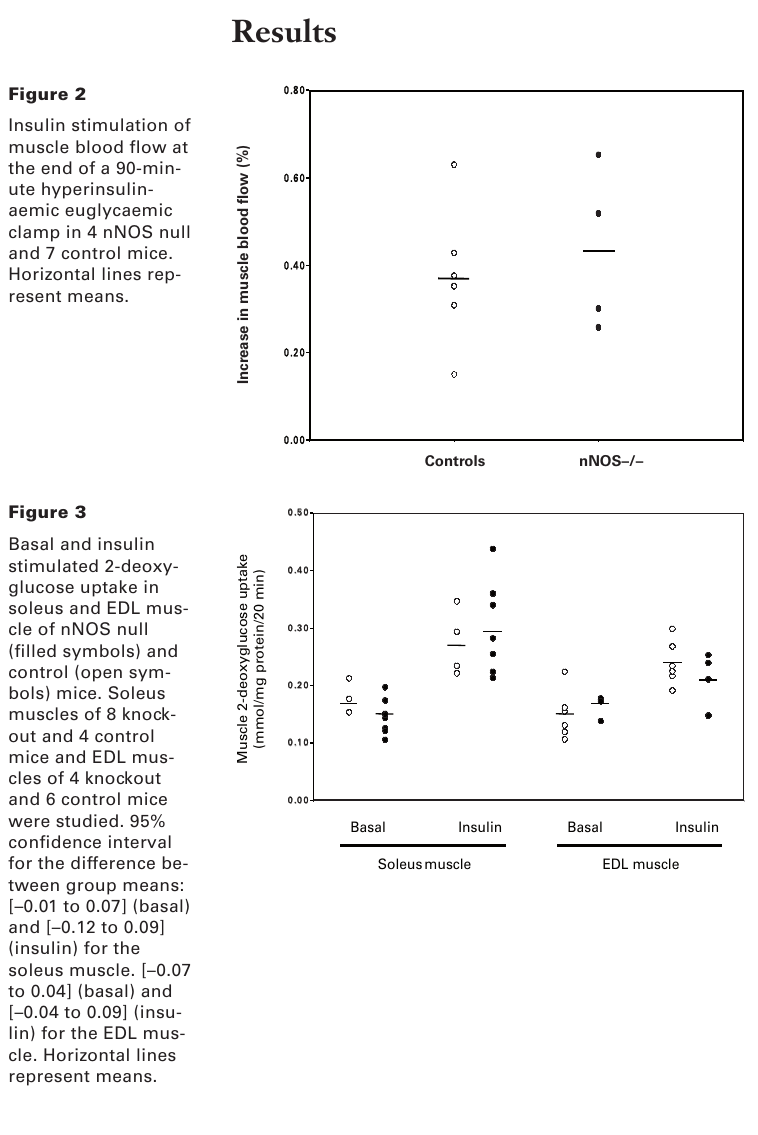
Figure 2 Insulin stimulation of muscle blood flow at the end of a 90-min - ute hyperinsulin - aemic euglycaemic clamp in 4 nNOS null and 7 control mice. Horizontal lines rep- resent means.